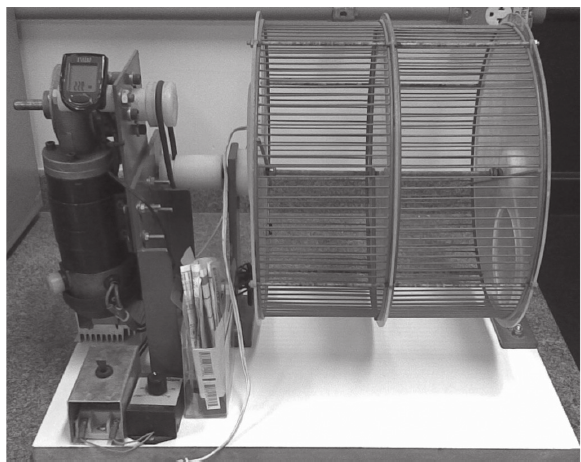
Figura 1 - Fotografia da roda de atividade construída me- diante projeto próprio do Laboratório de Fisiote- rapia Neurológica Experimental Fonte: Dados da